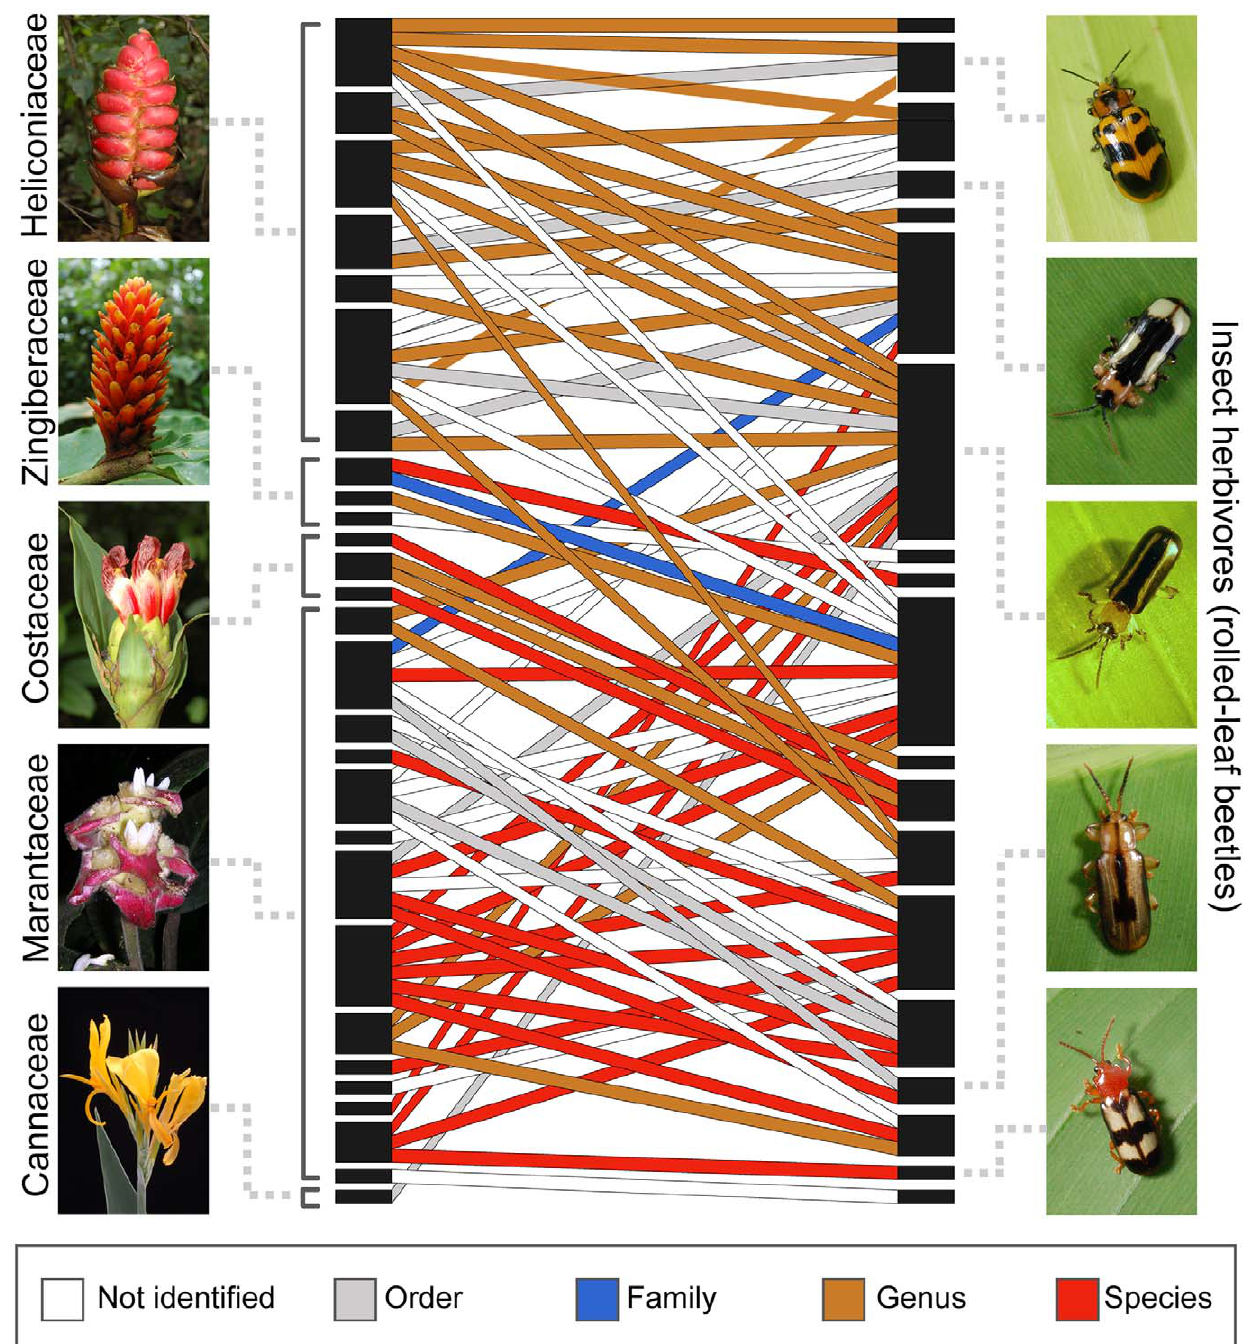
Figure 4. Reconstruction of a tropical plant-herbivore network using DNA extracted from insect gut contents. Rectangles represent insect herbivore and host plant species. Lines connect insect herbivores to their host plants. Line colors represent the taxonomic resolution at which each host plant association was identified. Rectangle size is proportional to its number of interactions. Host plant associations were inferred from rbcL and ITS2 DNA fragments. Fragments were compared to host plant DNA barcode libraries containing sequences of all potential hosts in the study area. Total of insect species=19. Total of plant species=28. Total of interaction=74. ( see matrix of associations in Table S1).